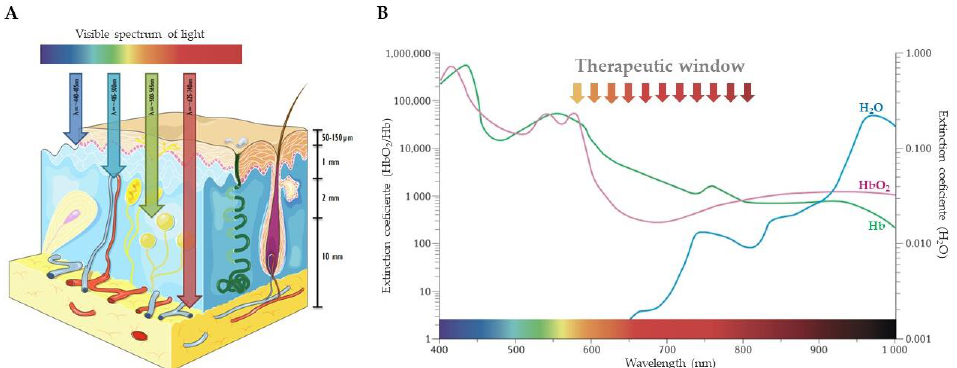
Figure 2. Light penetration into tissues. ( A ) The scheme represents a section of the epidermis-dermis. The arrows represent the depth of light penetration considering different wavelengths. Adapted from Laranjo, 2014 [98]. ( B ) Therapeutic window in the visible spectrum and extinction coefficient of water (H 2 O), hemoglobin (Hb), and oxyhemoglobin (HbO 2 ). Adapted with permission from Kobayashi et al., 2010 [99]. Copyright 2010 American Chemical Society.